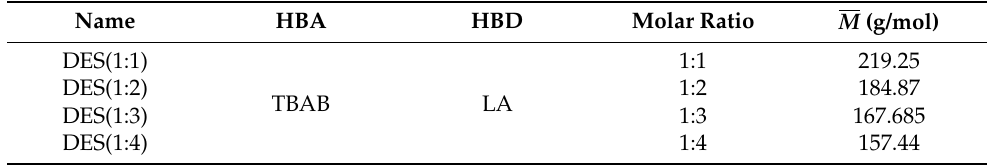
Table 2. DESs used in the present